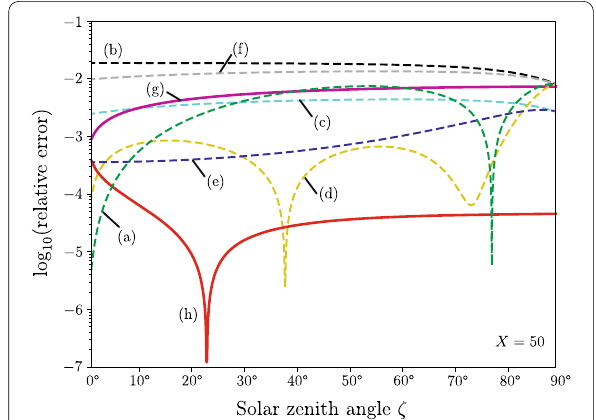
Fig. 1 Accuracy of analytical approximations of the Chapman function as a function of solar zenith angle ζ for scale parameter X 50 . The dashed lines show the formulas found in the literature = and solid lines correspond to approximations introduced in the present article (labeling in chronological order, see Table 1): a Green & Barnum approximation (Green and Barnum 1963), b Fitzmaurice approximation (Fitzmaurice 1964), c Swider approximation (Swider 1964), d Titheridge empirical formula (Titheridge 1988), e Kocifaj